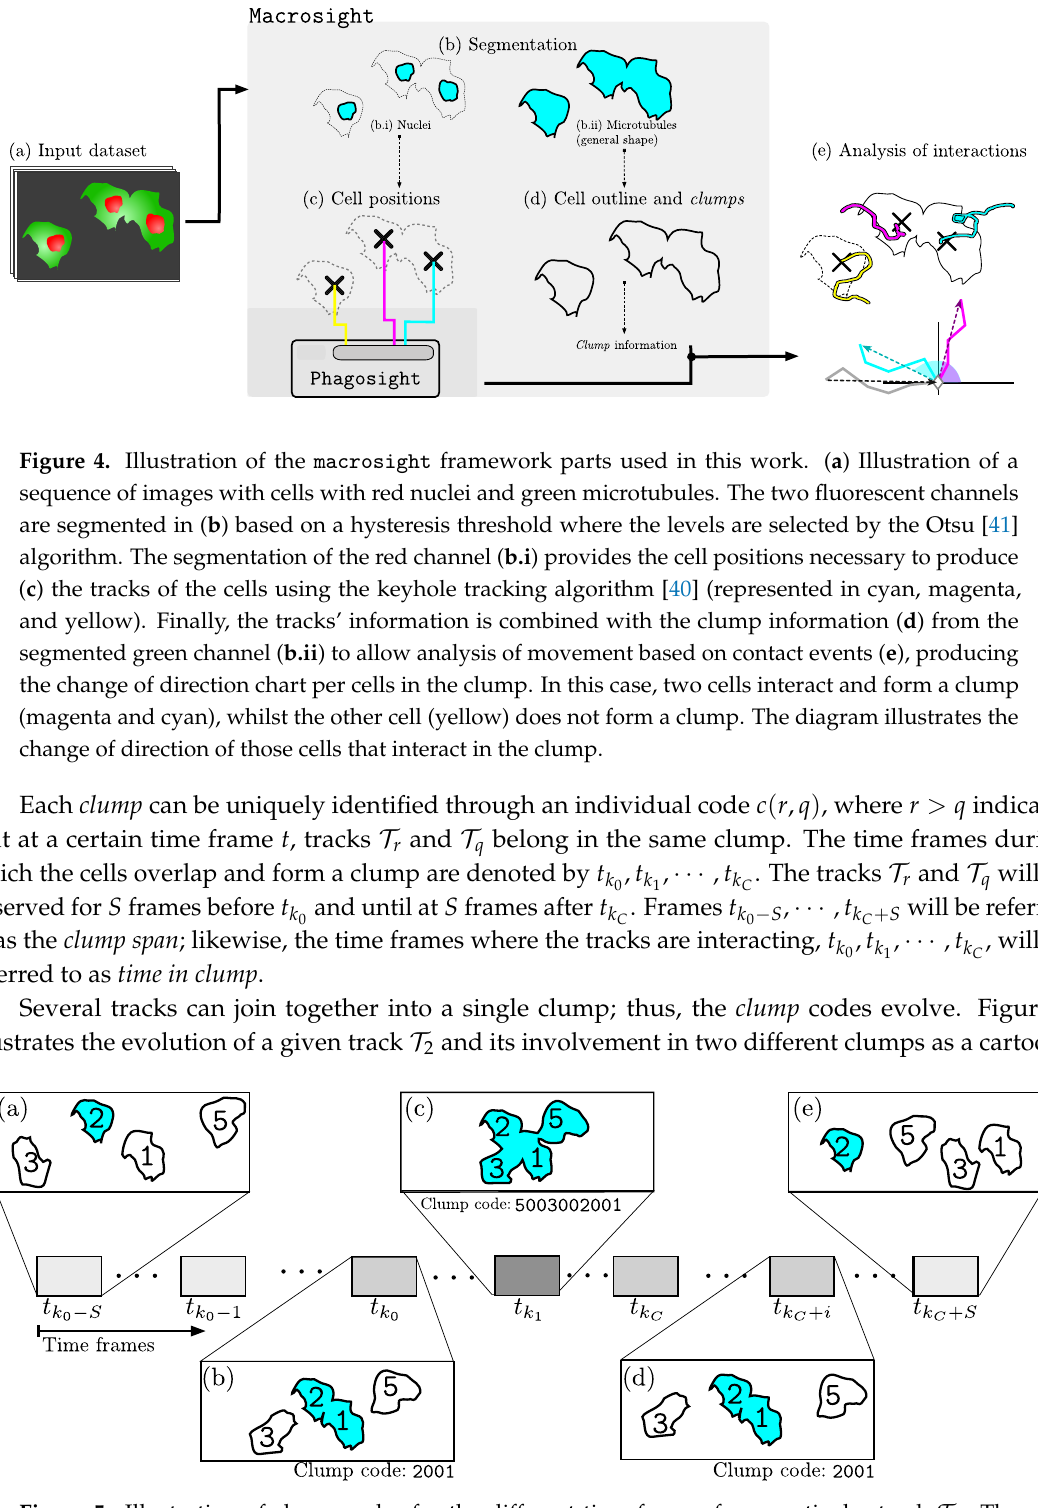
Figure 5. Illustration of clump codes for the different time frames for a particular track T 2 . The horizontal axis represents the time, and the detail of five frames is presented to illustrate the